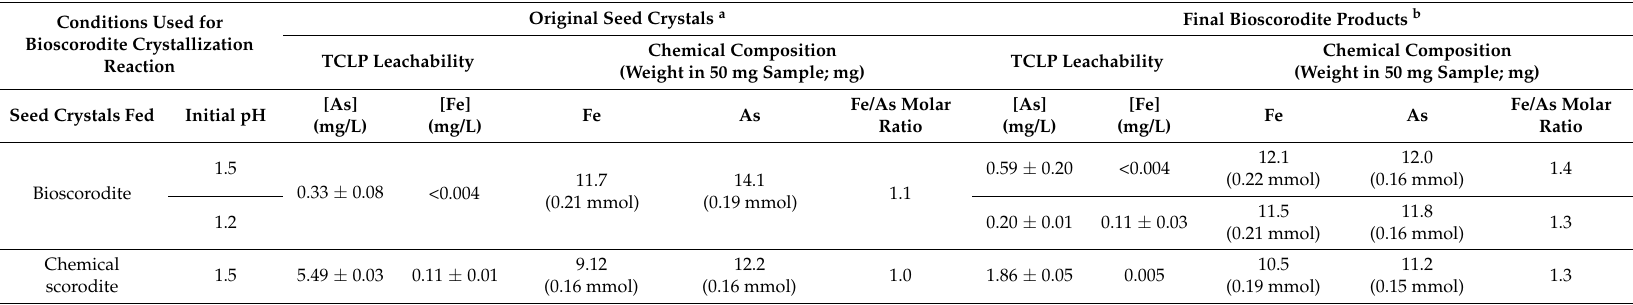
Table 2. TCLP test results for original scorodite seed crystals (bio- and chemical-) and final bioscorodite